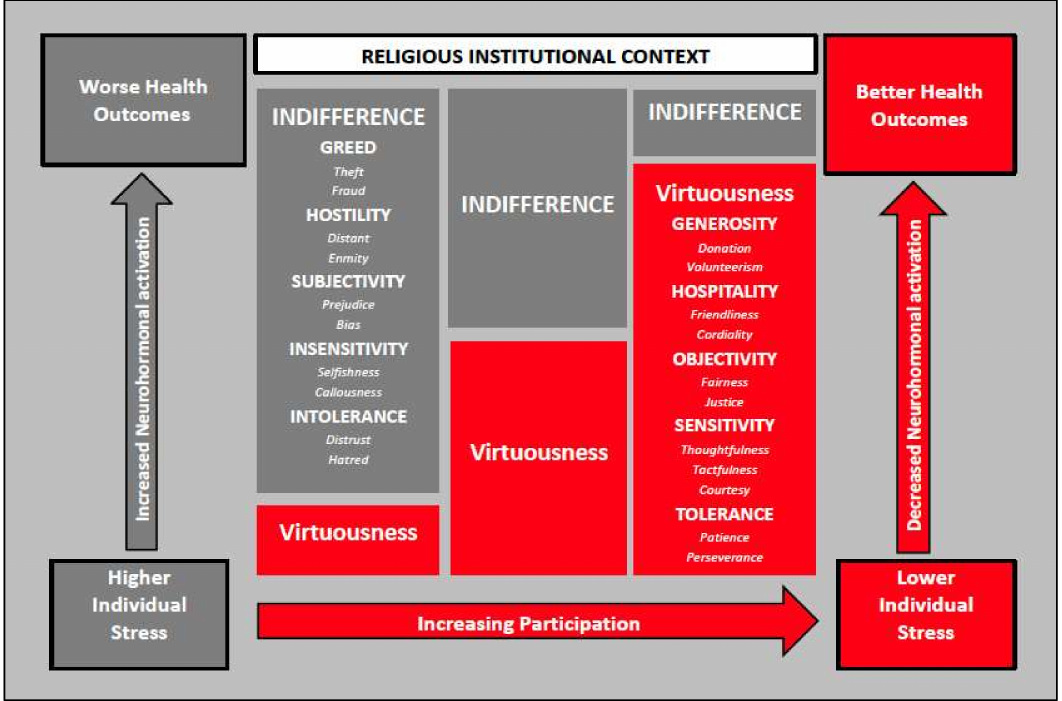
Figure 2. Religious institutional context and health outcomes adapted from Bruce and colleagues